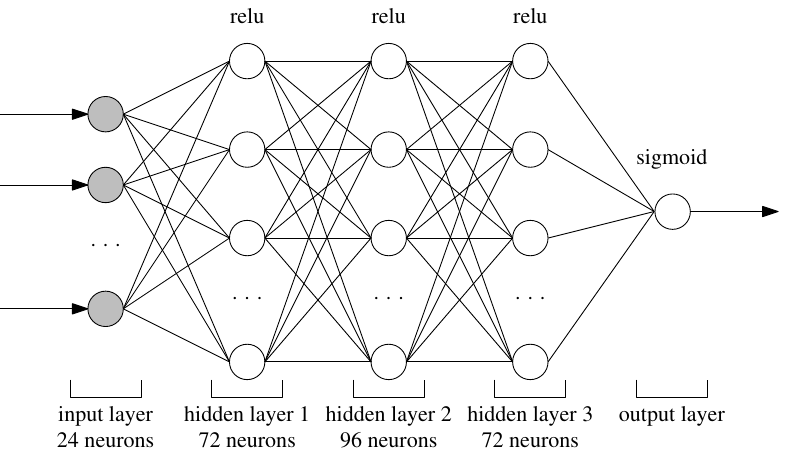
Figure 2. ANN structure for campaign classification